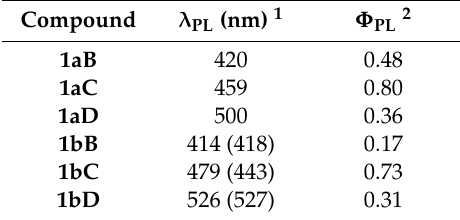
Figure 7. PL spectra of ( a ) 1aB – D and ( b ) 1bB – D crystals; ( c ) CIE chromaticity diagram calculated from the corresponding PL spectra. Table 3. Photophysical properties of 1aB – D and 1bB – D crystals.